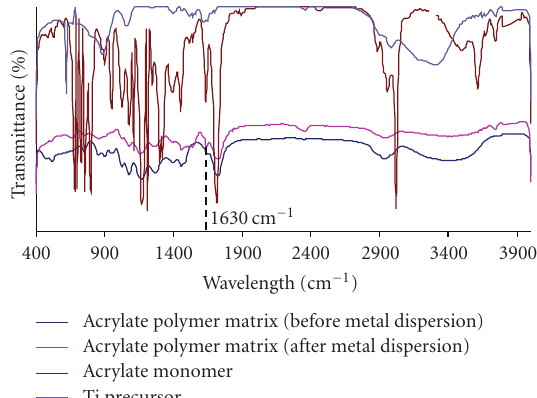
Figure 1: FTIR-Analysis of (a) Acrylate monomer, (b) Titanium precursor, (c) Acrylate polymer matrix (without metal dispersion), (d) Acrylate polymer matrix (with metal dispersion).